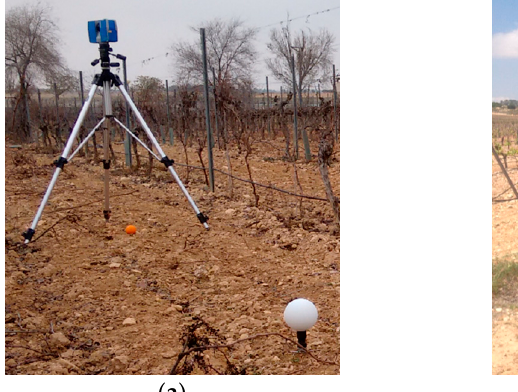
Table 1. The laser scanner’s technical